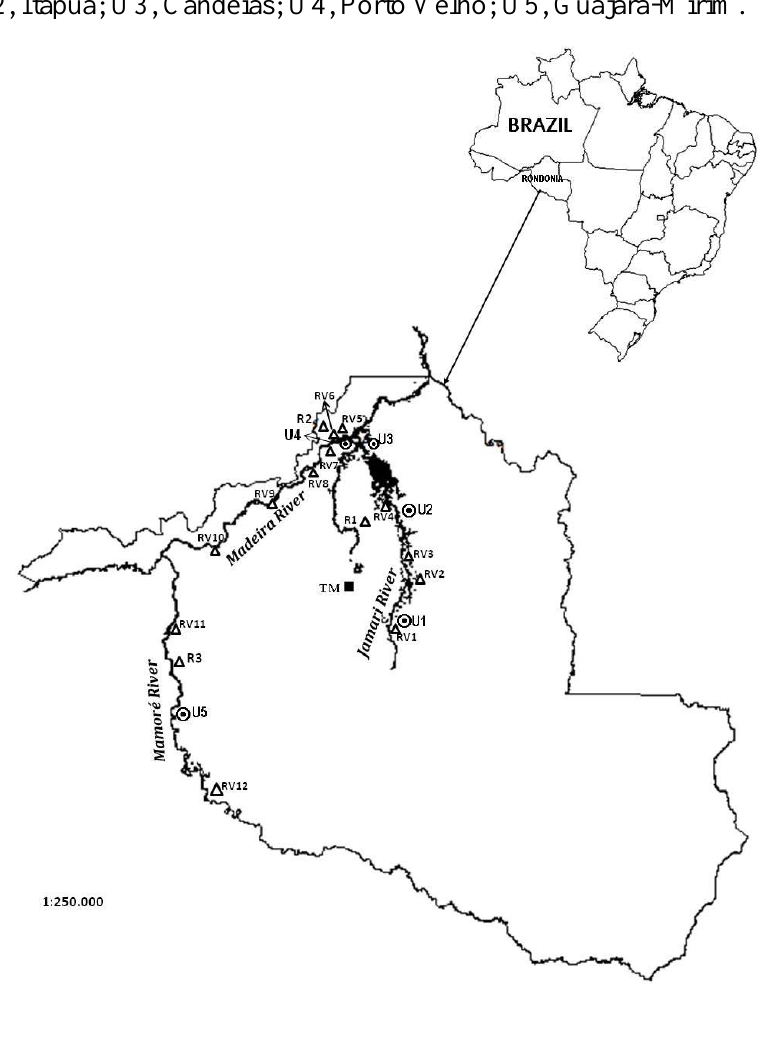
Figure 1. Map of the Madeira River basin illustrating the locations of the studied populations. TM, tin miners. Δ Rural and riverine communities: RV1, Marechal Rondon; RV2, Comunidade do Rio Preto do Crespo; RV3, Rei do Peixe; R1, Triunfo; RV4, Vila dos Pescadores; RV5, São Sebastião; R2, Vila Jatuarana; RV6, Engenho Velho; RV7, Santo Antonio; RV8, Teotônio; RV9, Jaci-Paraná; RV10, Mutum-Paraná; RV11, Vila Murtinho; R3, Vila Iata; RV12, Vila Surpresa.  Urban sampling sites.